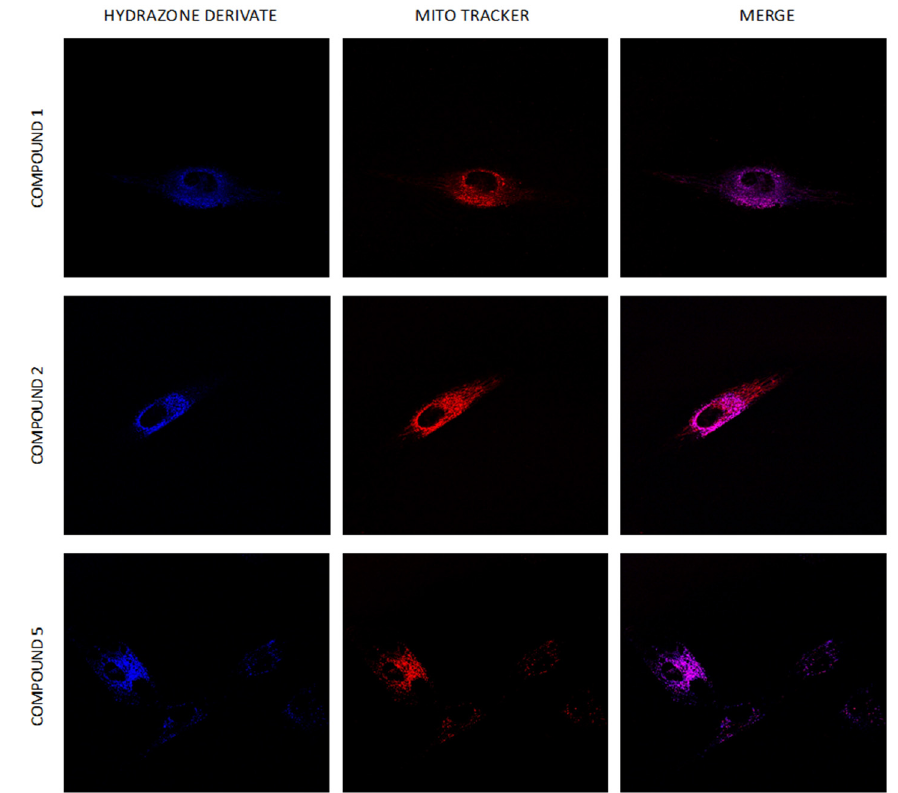
Figure 10. Uptake of hydrazone derivates 1 – 6 by HF-P4 cells. Compounds 1 – 6 at 1 µ M concentration were added to the cultivation media, and images of the localization of hydrazone derivates were taken at an indicated time (0.25 h). Lysosomes labelled with LysoTracker Green are shown in green, and mitochondria labelled with MitoTracker Red are shown in red. Fluorescence microscopy was done by Leica TCS SP8 WLL SMD-FLIM microscope with a water objective, HC PL APO CS2 63× (NA 1.2).